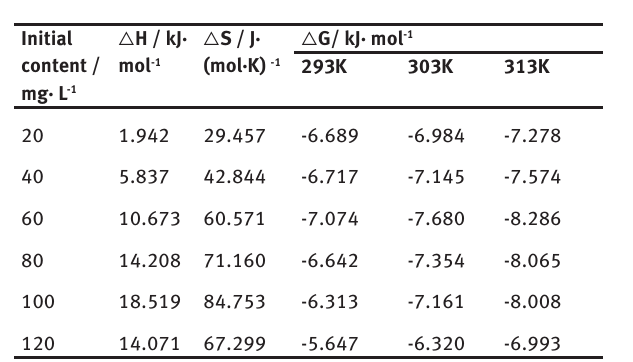
Table 4: Fitting results of the thermodynamic equations for Cu 2+ adsorption modeling.